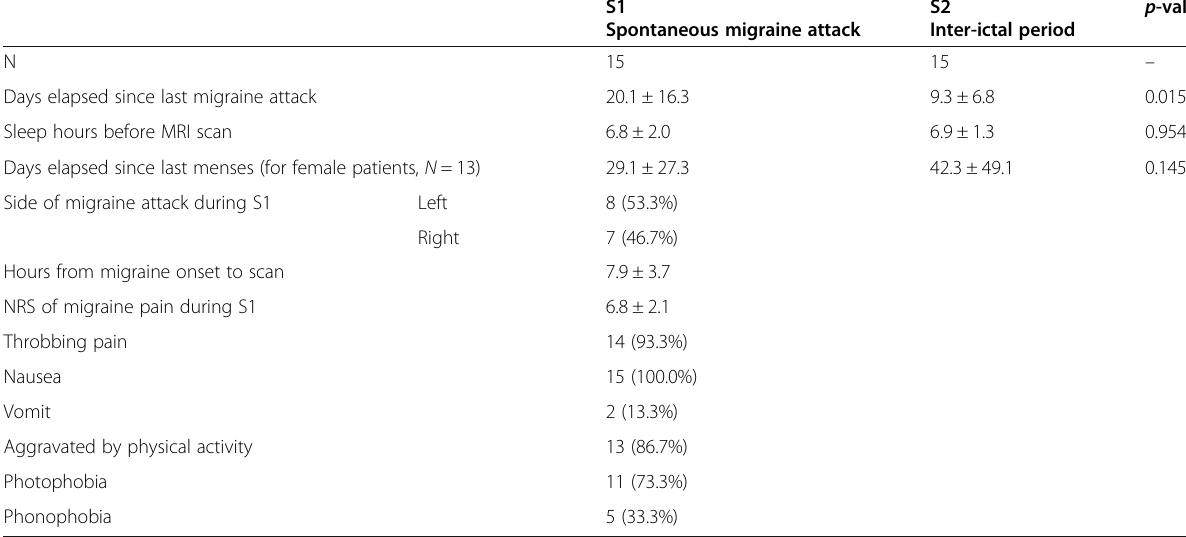
Table 2 Comparison of experimental conditions between S1 and S2 scans, and clinical phenotype of migraine attack recorded at